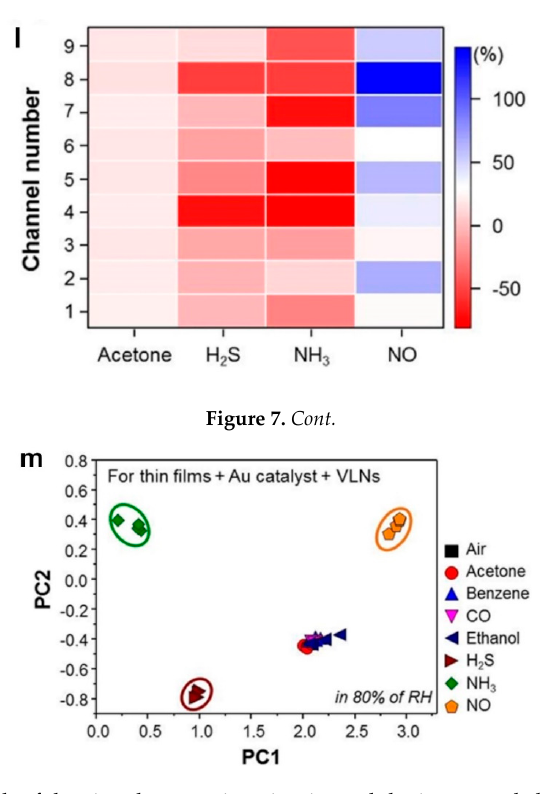
Figure 7. ( a ) Photograph of the signal processing circuits and the integrated chemiresistive electronic nose. ( b ) optical microscope images of the fabricated device with ( c ) a single chip containing an active layer on Pt interdigitated electrodes. ( d ) schematic illustration of the fabricated device consisting of an array of sensors. ( e ) Response patterns of the fabricated device to 8 different gases. FE-SEM images of ( f ) thin films, ( g ) Au functionalized thin films and ( h ) villi-like nanostructures with ( i–k ) the schematic illustration of sensing mechanism. ( l ) Color-coded response of the fabricated electronic nose to H 2 S, NH 3 , acetone and NO gases. (m) PCA plot showing thin films + Au functionalized thin films +VLNs responses to 8 gases in 80% RH [7]. Reproduced with permission [7], Copyright 2016, ACS Publications.